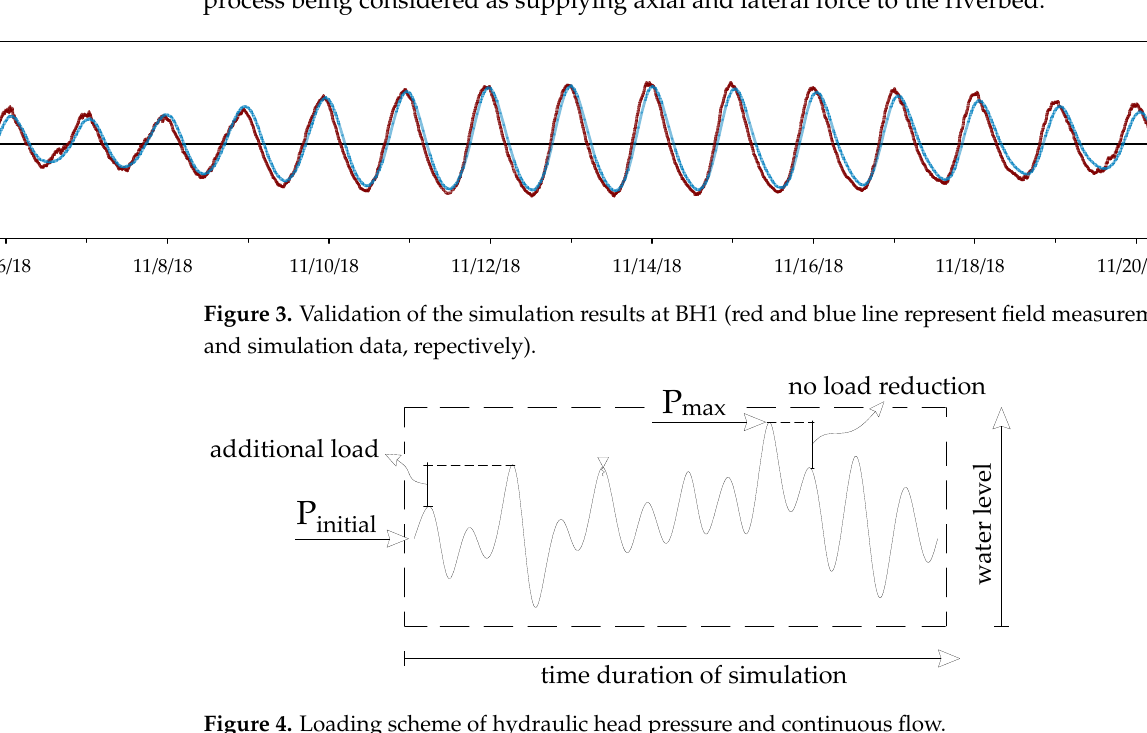
Figure 4. Loading scheme of hydraulic head pressure and continuous flow.